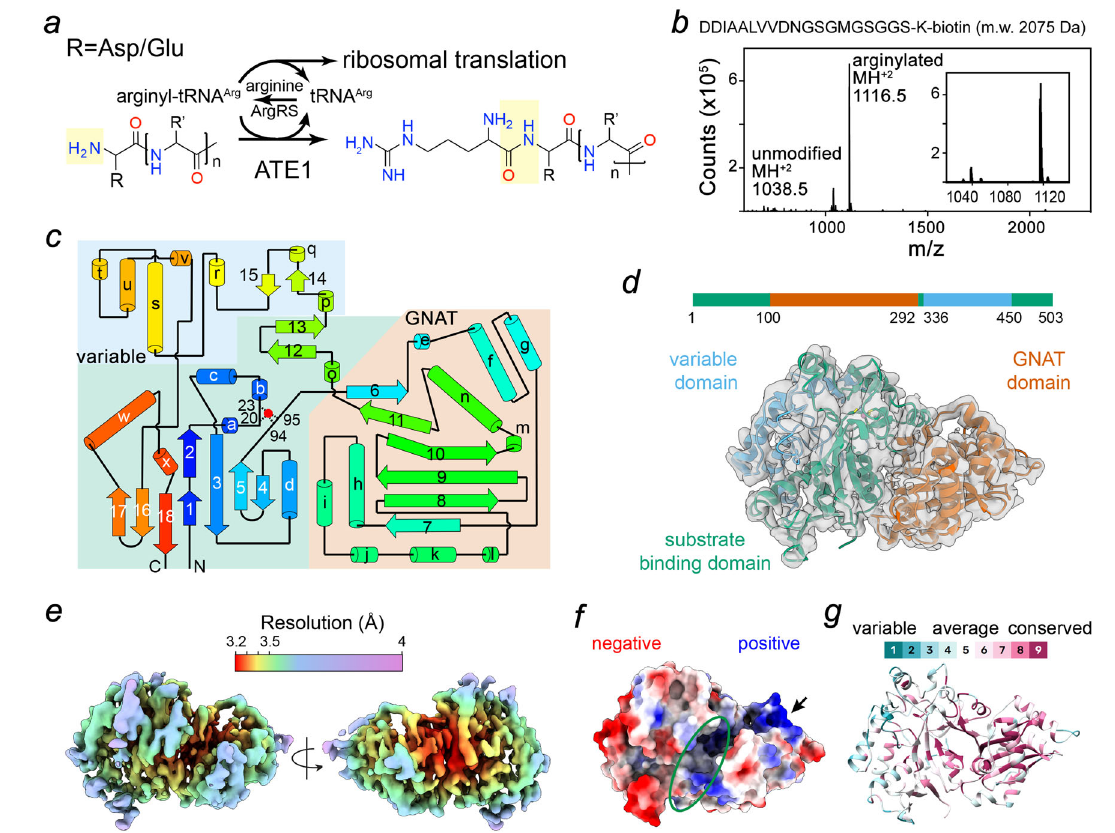
Fig.1|Proteinarginylationreactionandoverallstructureof S.cerevisiae